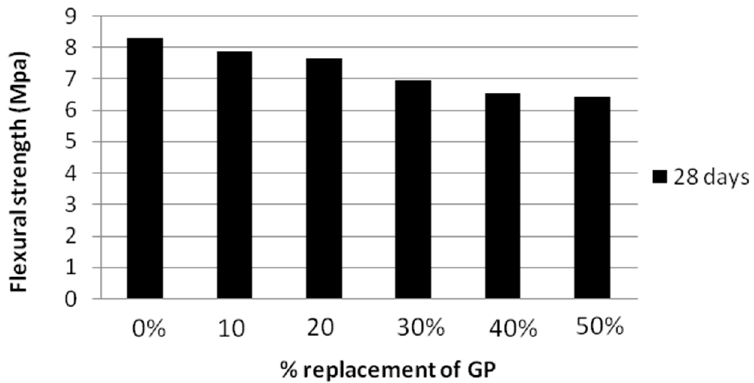
Figure 12. Flexural strength values of SCGM at various percentages of glass powder.